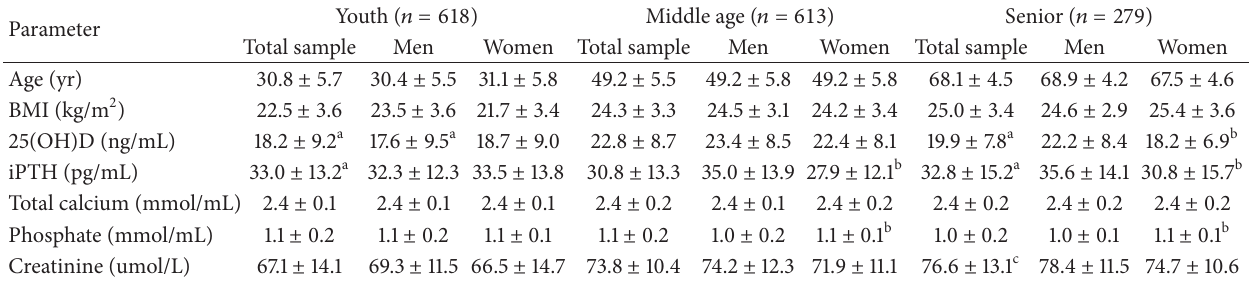
Table 2: Differences in the mean values of BMI, Serum 25(OH)D, PTH, calcium, Phosphorus, and Creatinine in different age groups ( 𝑛 = 1510